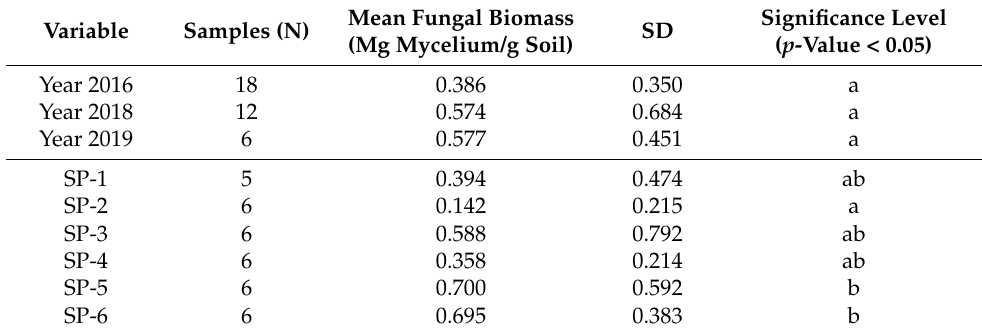
Table 3. Mycelia detected in soil for each variable in desert truffle